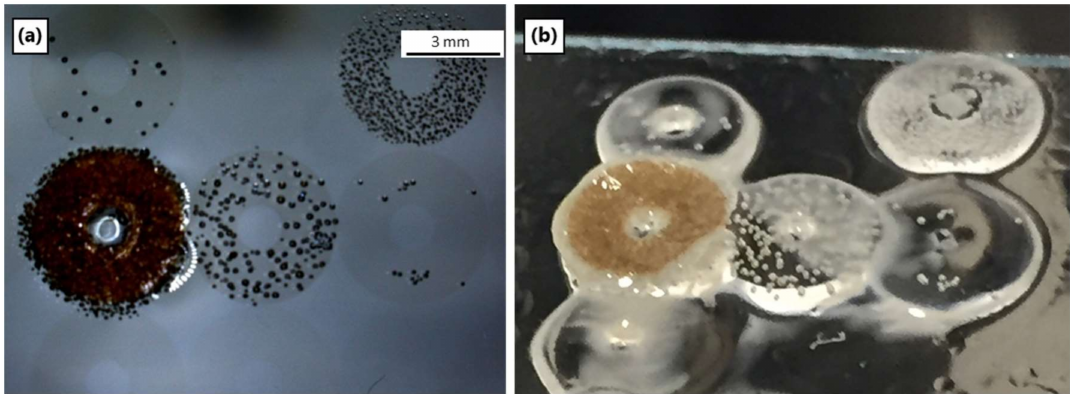
Figure 9. Ceraset green bodies via laser crosslinking at 355 nm: ( a ) before and ( b ) after solvent washing. For the top row, laser power was 130 mW with focus off by 3 mm for the left disc and 1 mm for the disc on the right. The second and third rows of discs were formed with the laser focus 5 mm and 10 mm above the sample. Laser power for both rows was decreased from left to right 560 mW, 400 mW, 280 mW. In the third row, only the first disc survived solvent